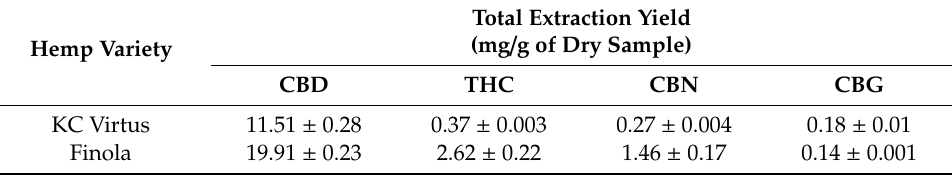
Table 2. Total extraction yields obtained with Soxhlet extractions of hemp varieties. Hemp Variety